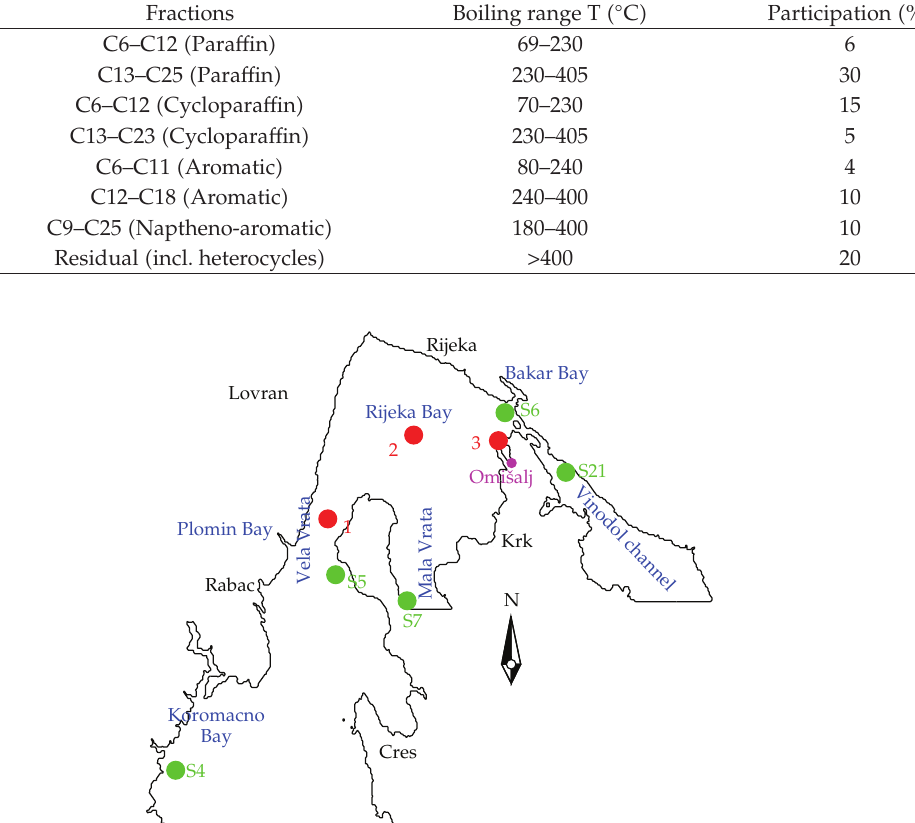
Figure 2: Hypothetical positions of oil spills marked with red squares (cid:4)(cid:4) 1 (cid:5) Vela Vrata, (cid:4) 2 (cid:5) center of the Rijeka Bay, (cid:4) 3 (cid:5) entry to the Omiˇsalj terminal (cid:5) and positions of current meter stations with green squares S4, S5, S6, S7, and